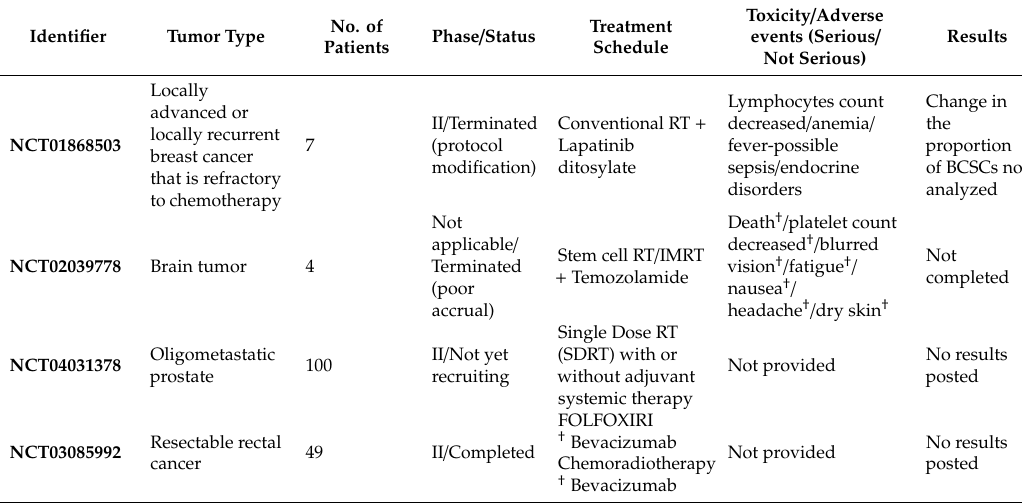
Table 1. Clinical trials combining CSC and